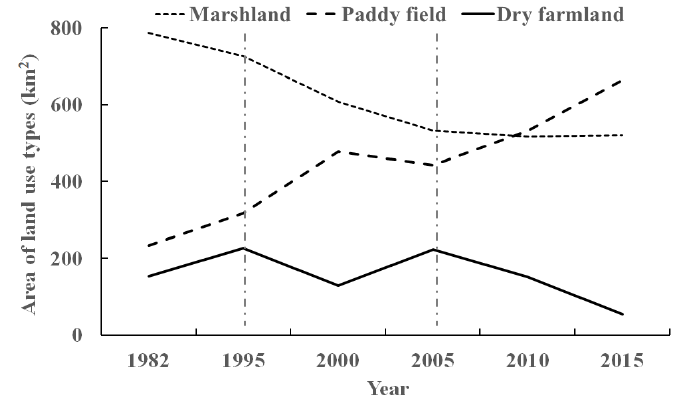
Figure 2. Changes of land use over different years.